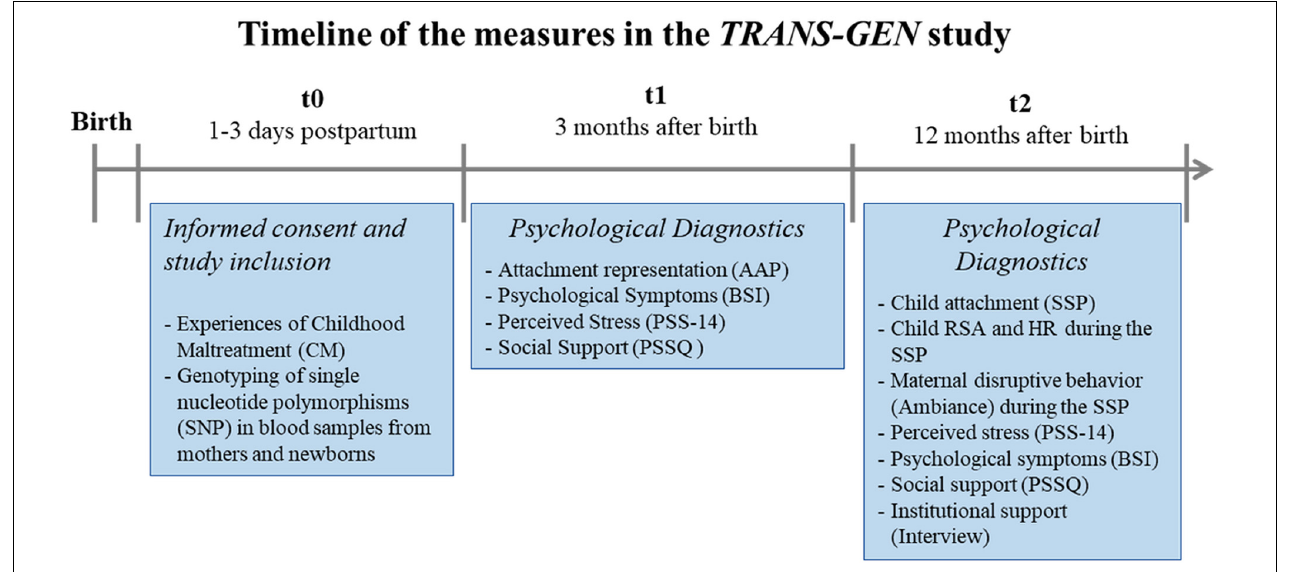
FIGURE 2 | Time line of the measures in the TRANS-GEN